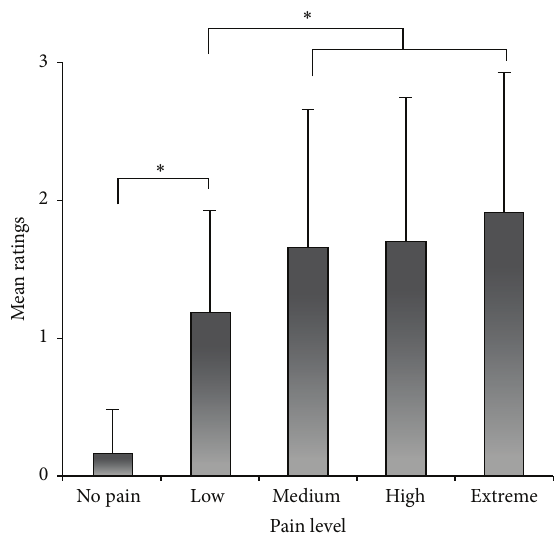
Figure 2: Preschoolers’ mean pain ratings attributed to the different pain intensity levels for visual stimuli depicting faces showing expressions of pain or neutral expressions. Error bars represent 1SD. Significant differences (𝑃 < 0.005) are indicated by an asterisk.